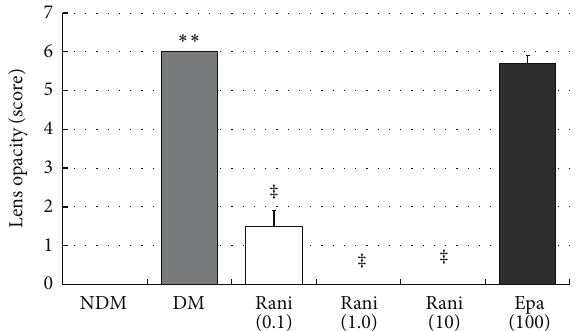
Figure 6: The MNCV levels in the sciatic nerves at 40 weeks. The MNCV levels in the sciatic nerves of the untreated SDT rats at 40 weeks are significantly lower than those of the SD rats. ∗∗ 𝑃 < 0.01 , Student’s 𝑡 -test. The MNCV levels in the sciatic nerves of the SDT rats treated with ranirestat and those treated with epalrestat are significantly higher than those of the untreated SDT rats. ‡ 𝑃 < 0.01 , Dunnett type mean rank test and † 𝑃 < 0.05 , Student’s 𝑡 -test. NDM: non-diabetes mellitus; DM: diabetes mellitus; rani: ranirestat; epa: